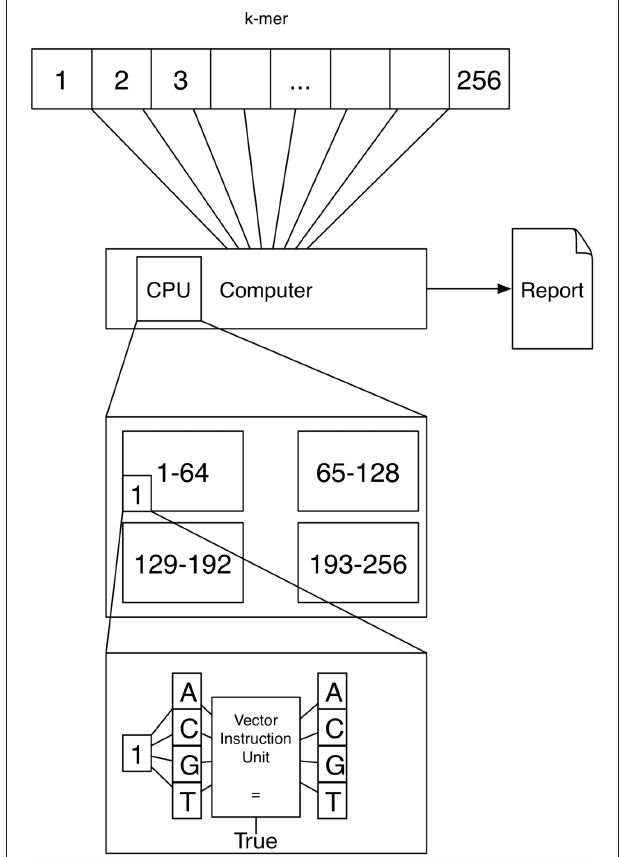
FIGURE 2 | Vector instruction units are located inside a processor and can execute a single instruction on multiple data at once. This means that for example comparing four character-pairs is (almost) as fast with vector instructions as comparing 1